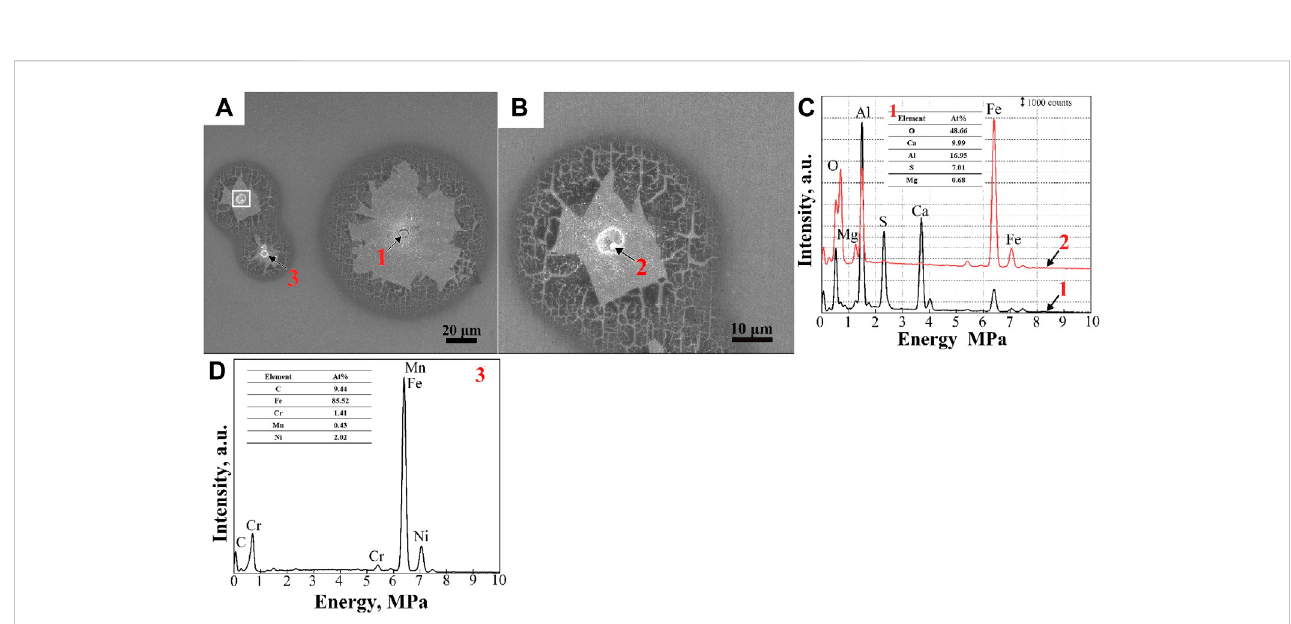
FIGURE 13 SEMmorphologiesofpitcorrosionintheBM (A) andthepitnucleus (B) markedbythewhiteboxin (A) athighermagni fi cation.TheEDSmaps (C,D) ofthe pit nucleus are marked by 1, 2, and